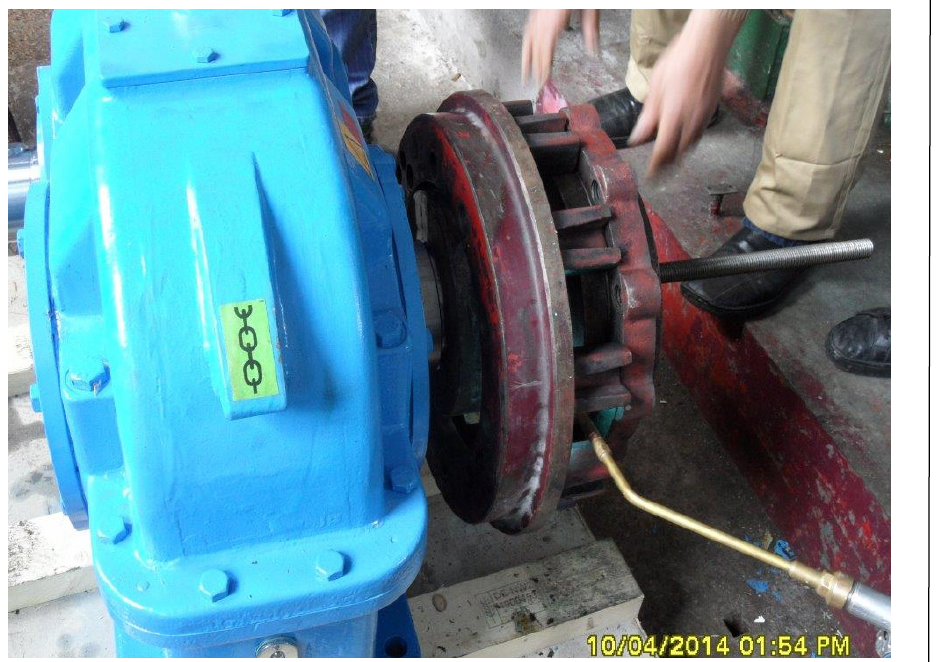
Figure 5 – High-quality installation of assemblies using the new device for dismantling and